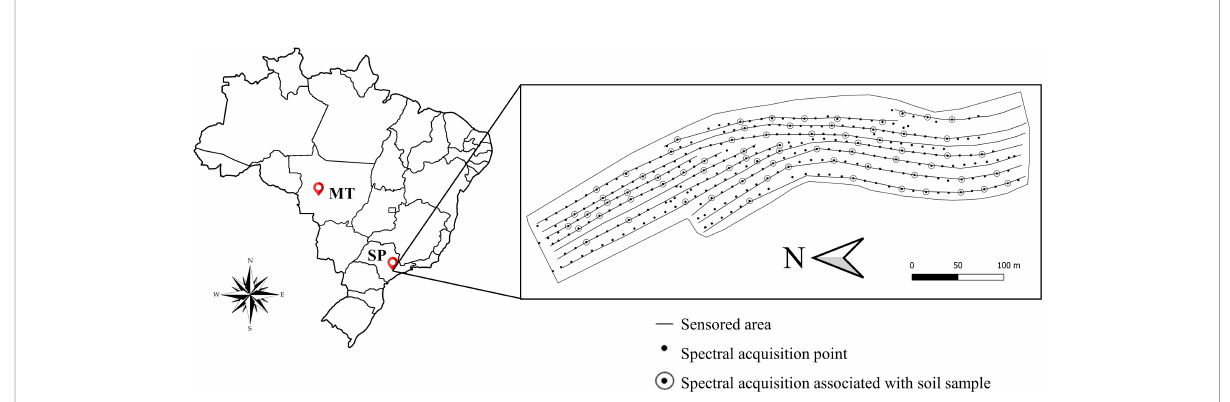
FIGURE 2 Location of areas from where samples were acquired for models ’ calibrations. Highlighted, located in Piracicaba, São Paulo State (SP), the experimental fi eld shape, sensored transects, spectral points acquisition, and associated soil samples. Samples from another fi eld nearby were used to compose geological dataset. Global dataset was built by adding samples from another area, located in Mato Grosso (MT)